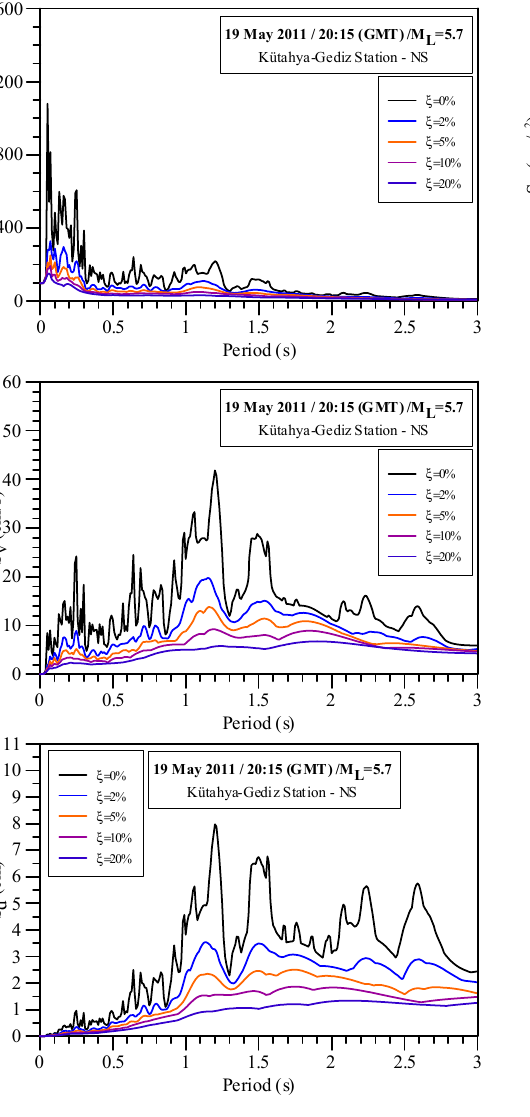
Figure 6. Acceleration, velocity and displacement response spectra with different damping ratios for NS and EW components of the ground motion recorded at the Gediz station during the Simav